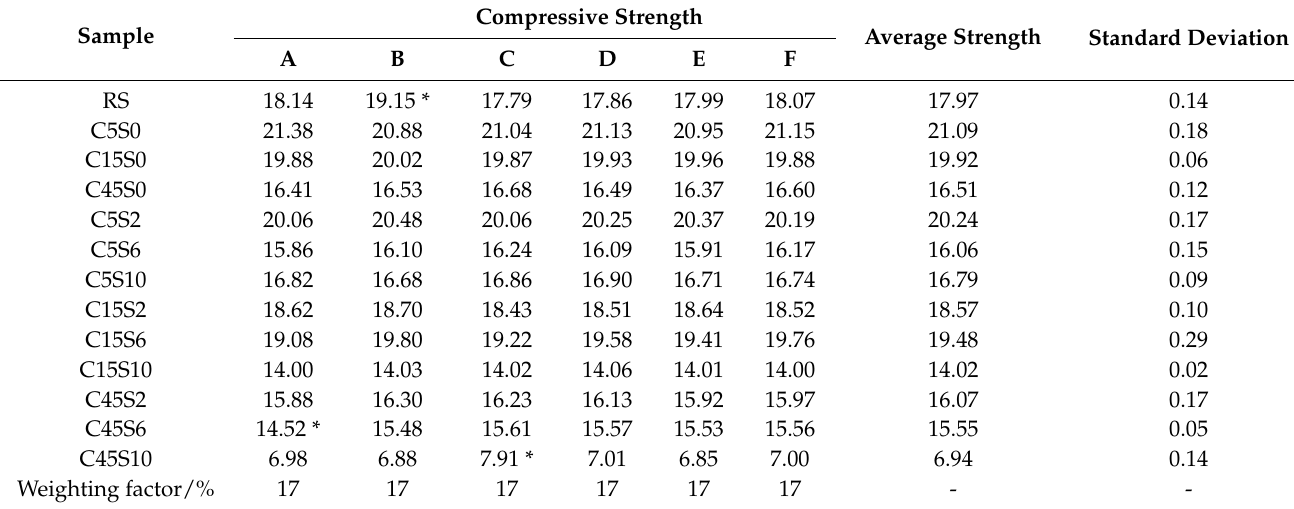
Table A3. Original data of compressive strength test (unit: MPa).